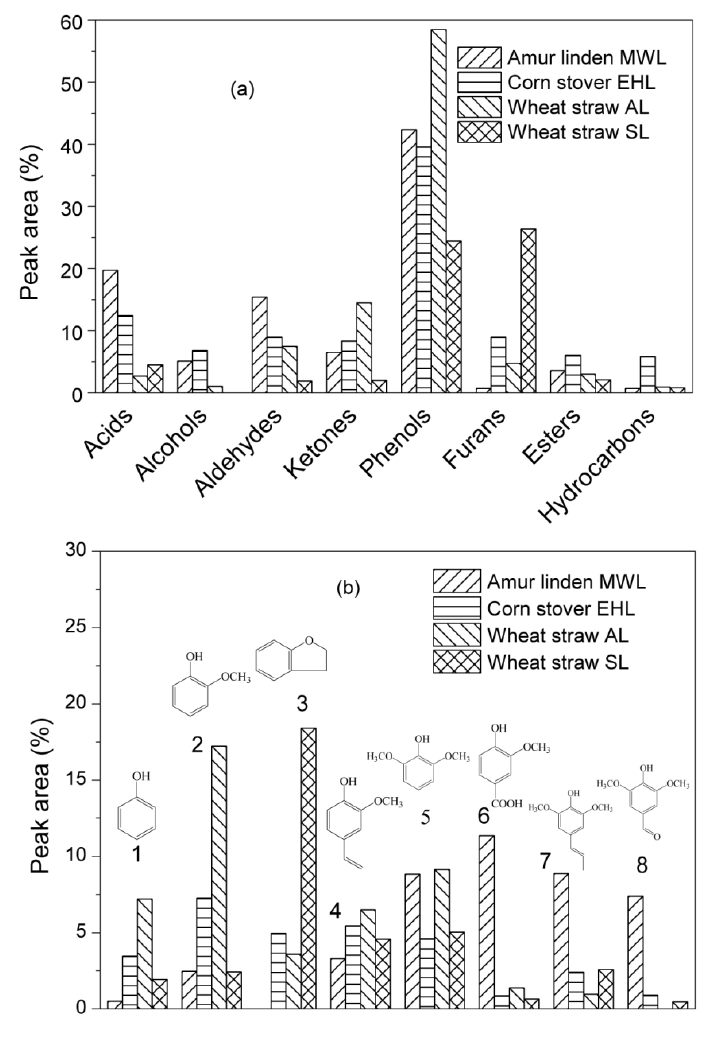
Figure 3. ( a ) Comparison of the product distributions from the pyrolysis of the four lignins. ( b ) Specific typical compounds produced by pyrolyzing the four lignins. MWL: milled wood lignin; EHL: enzymatic hydrolysis lignin; AL: alkali lignin; SL: sulfonate